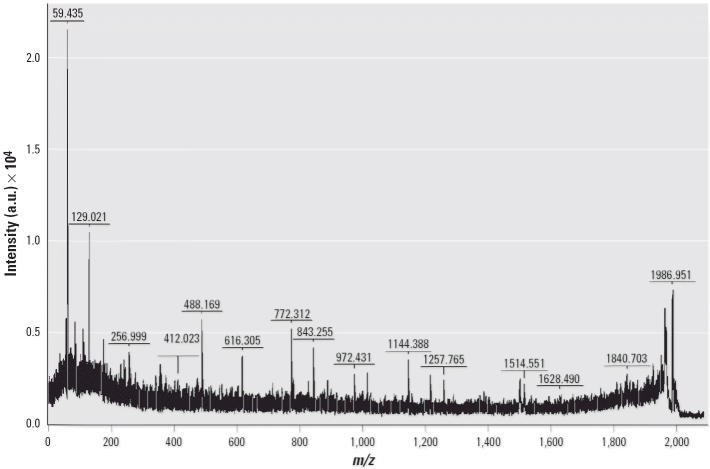
MS/MS identification of Gap-43 (neuromodulin). MS/MS spectrum for spot 10 in Figure 2A. The parent ions m/z 1986.91 and 1217.56 were used for MS/MS identification.